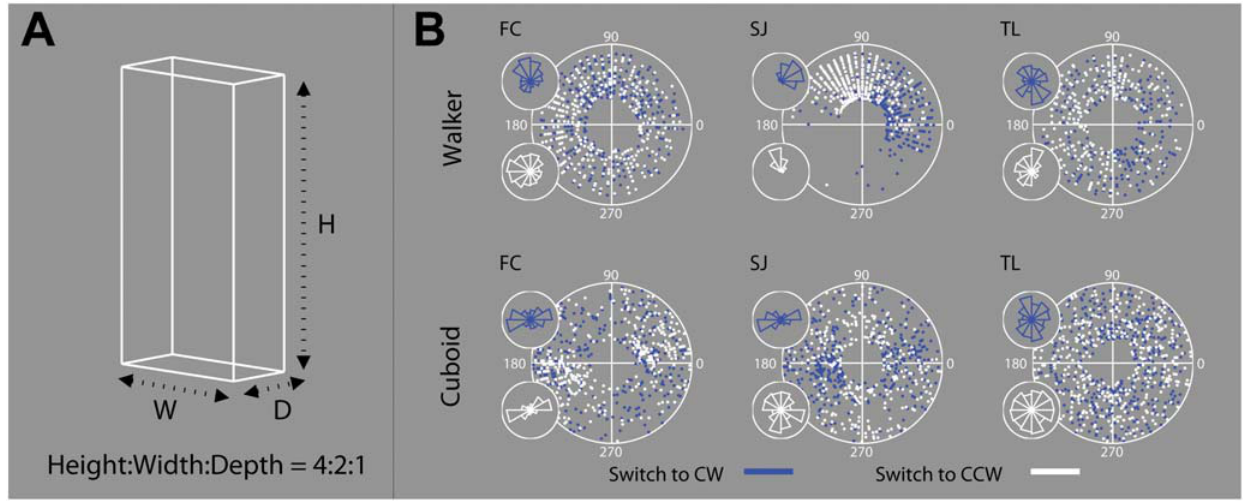
Figure 8. Object-type and reversal location. (A) An ambiguous rotating cuboid was presented in half of the trials in Experiment 3. The cuboid was presented as though the observer was looking down on the top of the object from a 10 u elevation. Without this a 3-D structure is not visible under rotation (instead only the four vertices are seen, translating as lines). A side effect of this elevation is that the percept of ‘looking down’ on the cuboid is generally more prevalent than the alternative percept [34]. As our focus in Experiment 3 was on the locations of percept transition, and not dominance durations per se, we ignored this aspect of the cuboid’s reversal dynamics. (B) Switch to CW (dark blue dots) and Switch to CCW (white dots) were monitored in separate blocks of six 1-min trials. Four blocks were completed in each repetition, one for each transition-stimulus pairing, presented randomly.